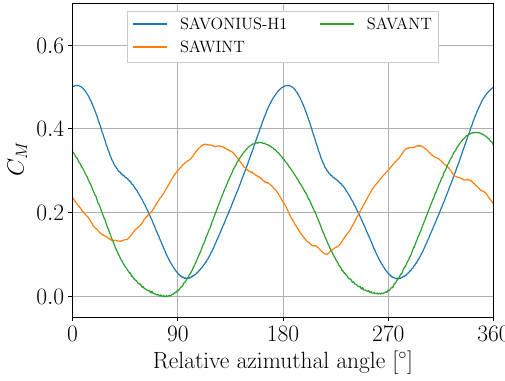
10 5 , 1.20 10 6 and 2.24 10 5 , × × ×